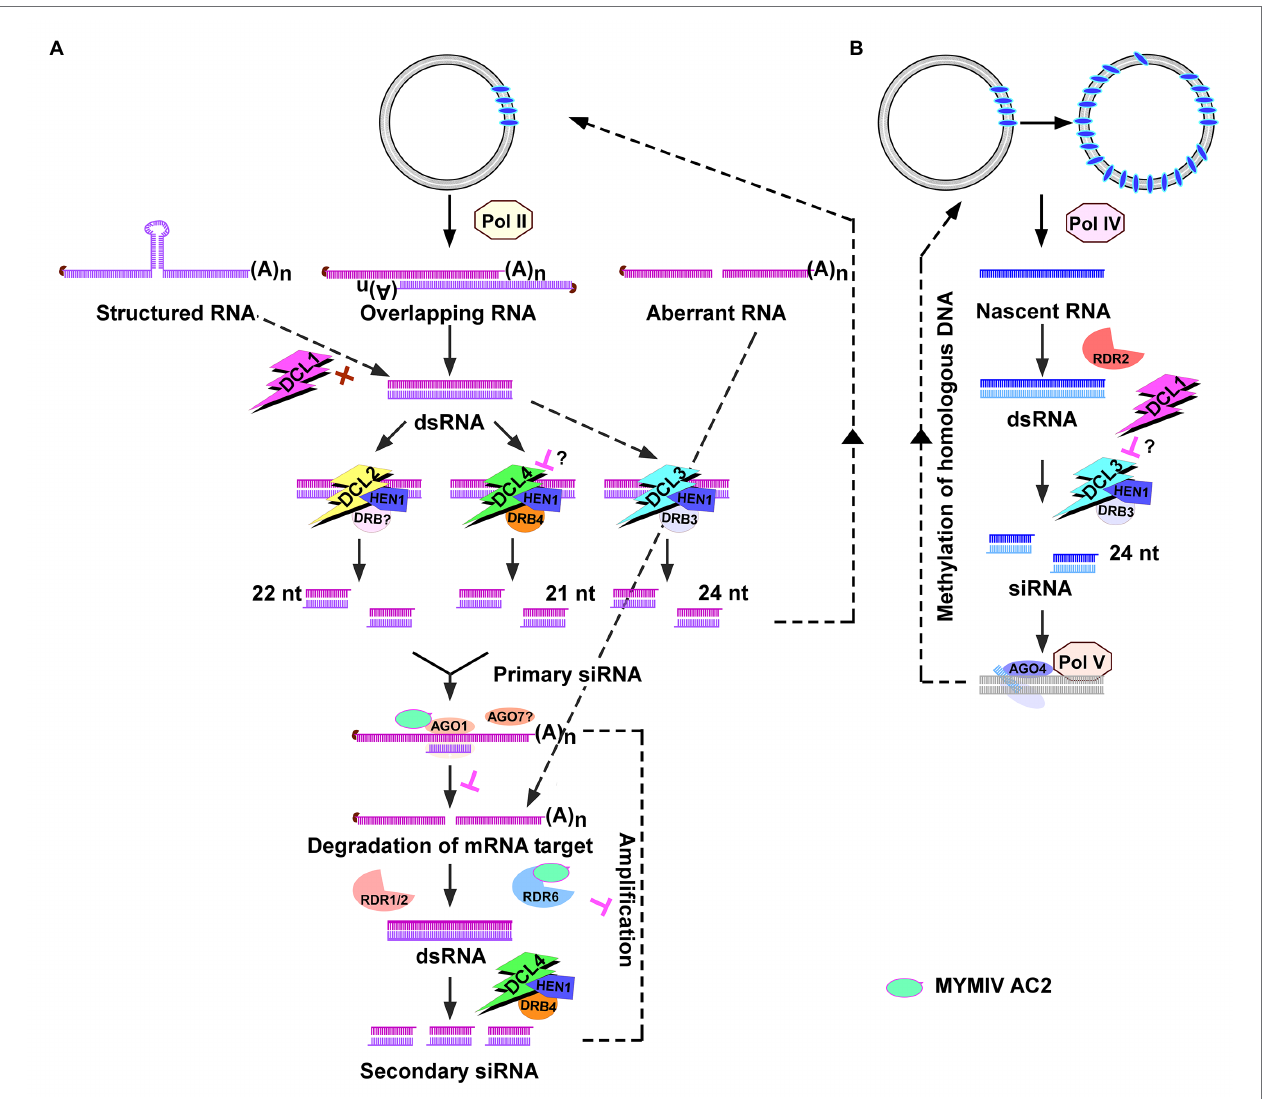
FIGURE 3 | Geminiviral siRNA pathways. (A) Post-transcriptional gene silencing (PTGS) pathway. The host RNA polymerase transcribes the replicative form of virus into structured/overlapping/aberrant transcripts which are processed into 21 nt siRNA by DICER-LIKE4/DCL4. DCL2 generates 22 nt siRNAs in the absence of DCL4. DCL1 acts as a positive regulator (+) by facilitating dsRNA access to other DCLs. The role of DCL1 as a negative regulator ( ┴ ) of DCL4 and DCL3 in geminiviral siRNA pathway is not clear (?). The 21 nt siRNAs-Argonaute1 (AGO1) target viral transcripts for slicing by the endo-ribonuclease activity of AGO1. The role of AGO7 in geminiviral defense is not clear (?). The sliced mRNA transcript serves as a template for RNA-DEPENDENT RNA POLYMERASE1/2/6 (RDR1, -2, -6) to convert it into dsRNA, which thereafter generates secondary siRNAs to amplify the host defense response. Suppression of PTGS by binding AGO1 and RDR6 by Mungbean yellow mosaic India virus (MYMIV) AC2 is denoted. (B) Transcriptional gene silencing (TGS) pathway. The Pol II transcribed dsRNA is processed by DCL3 (when DCL2 and DCL4 are saturated) into 24 nt siRNAs which cause de novo methylation of viral genome. The methylated viral genome is transcribed by Pol IV to produce a nascent transcript, which is converted to dsRNA by RNA-DEPENDENT RNA POLYMERASE2/RDR2. dsRNA is processed by DCL3 into 24 nt siRNAs. The complex of 24 nt siRNA-AGO4 targets the Pol V-generated scaffold transcript to mediate RNA-directed DNA methylation. DRB, double-stranded RNA binding proteins and HEN1, HUA ENHANCER1